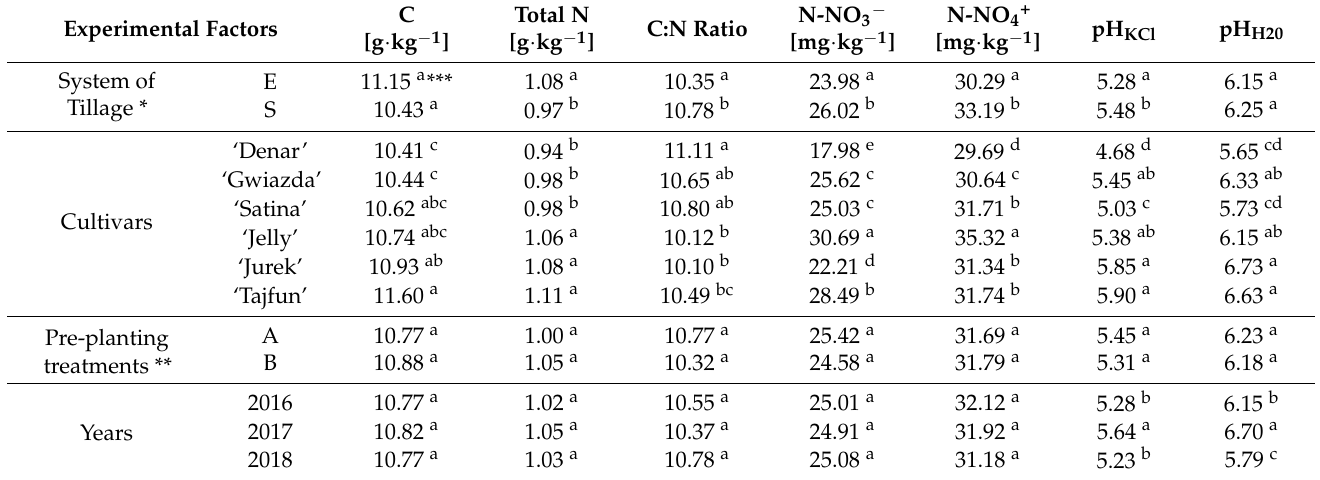
Table 7. Physical and chemical properties of soil under cultivation of potato. Experimental